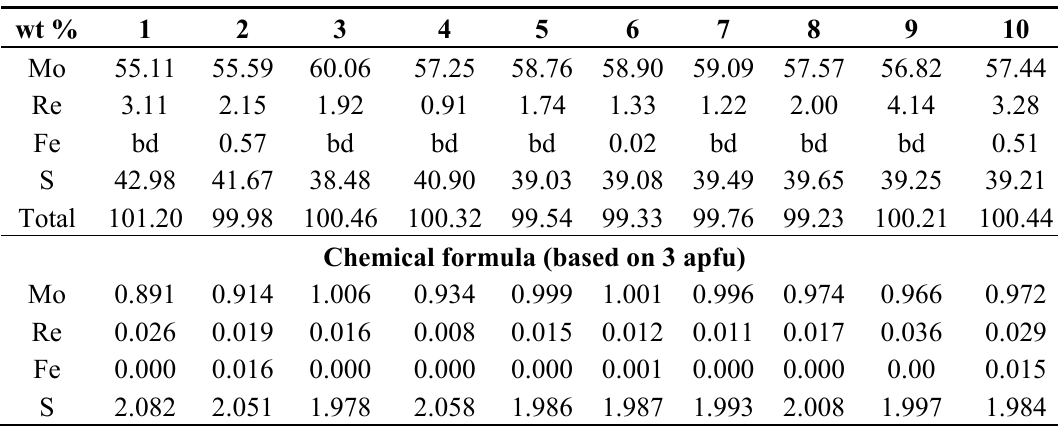
Table 2. Representative electron microprobe analyses and atomic proportions of molybdenite from Konos (1,2), Myli (3,4), Melitena (5,6), Maronia (7,8) and Pagoni Rachi (9,10); bd: below